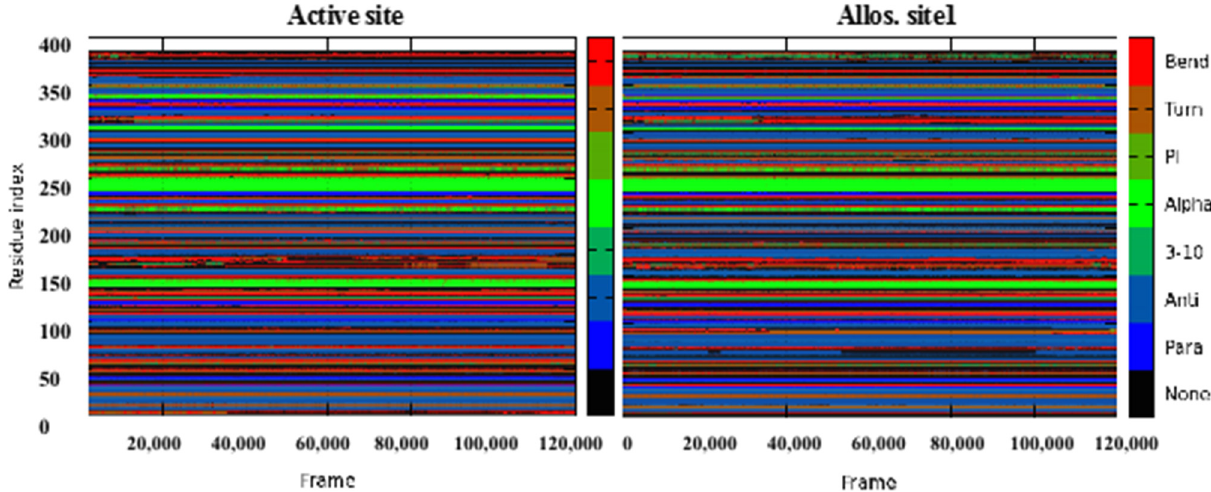
Figure 8. Protein secondary structure prediction per 385 residues over time 120 ns (120,000 frames) for compound 1 binding to BACE1 active site and allosteric site 1 .